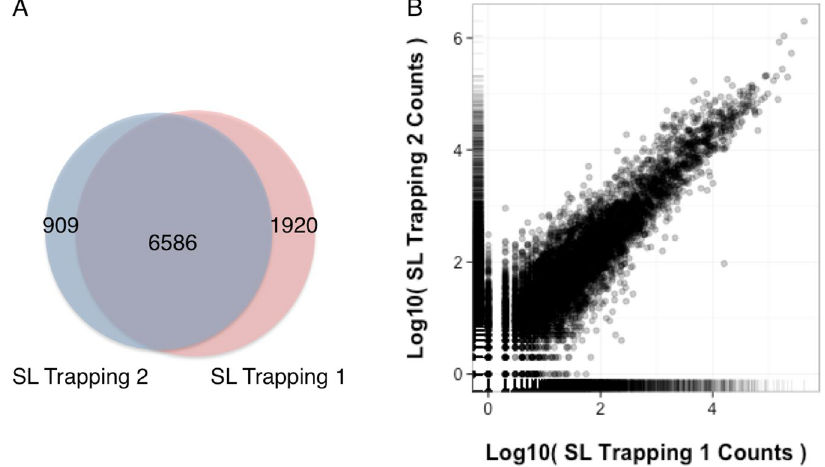
Figure 1. Comparison between the two SL Trapping experiments. ( A ) Shared genes between the two independent biological replicates, SL Trapping 1 (pink) and SL Trapping 2 (blue). ( B ) Correlation of gene counts between the two SL Trapping datasets (Pearson correlation coefficient =